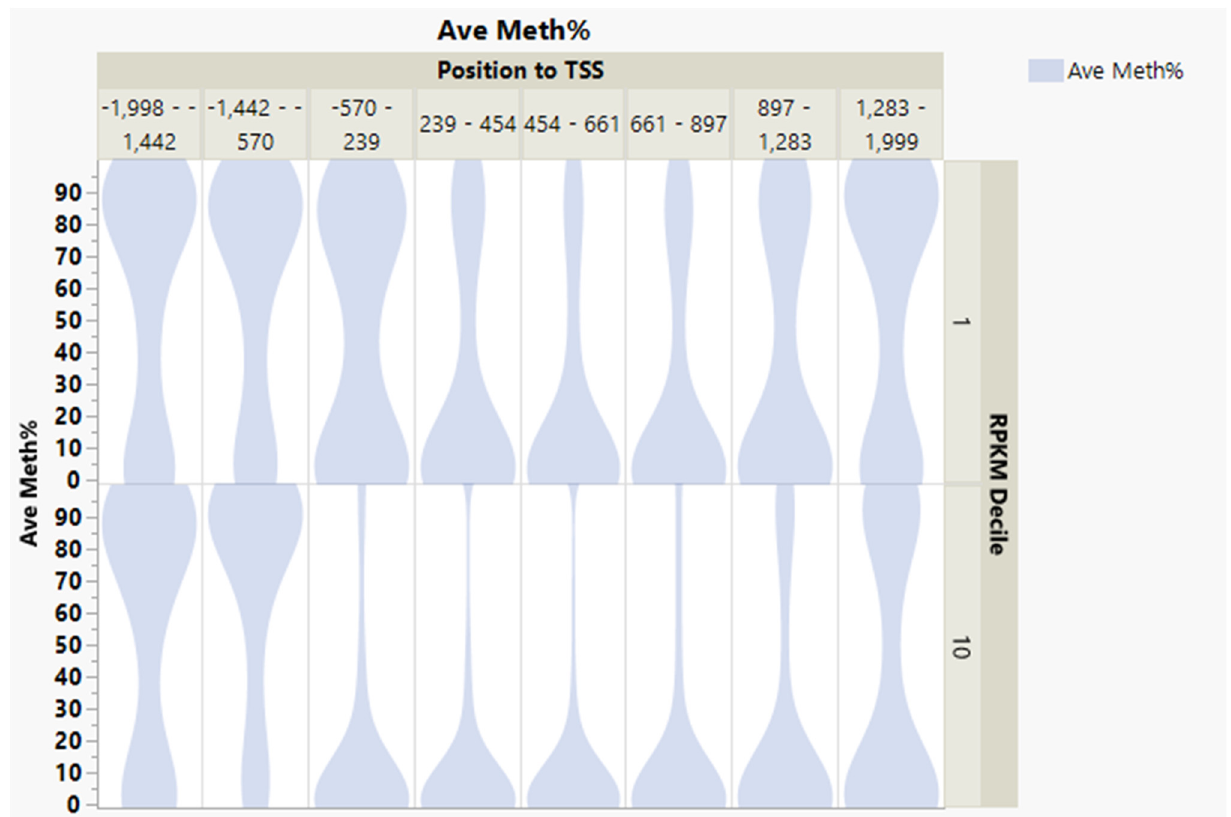
Figure 9. Silenced genes (RPKM Decile 1) in rainbow trout muscle have more hypermethylated CGIs in the promoter region compared to the most highly expressed genes (Decile 10).